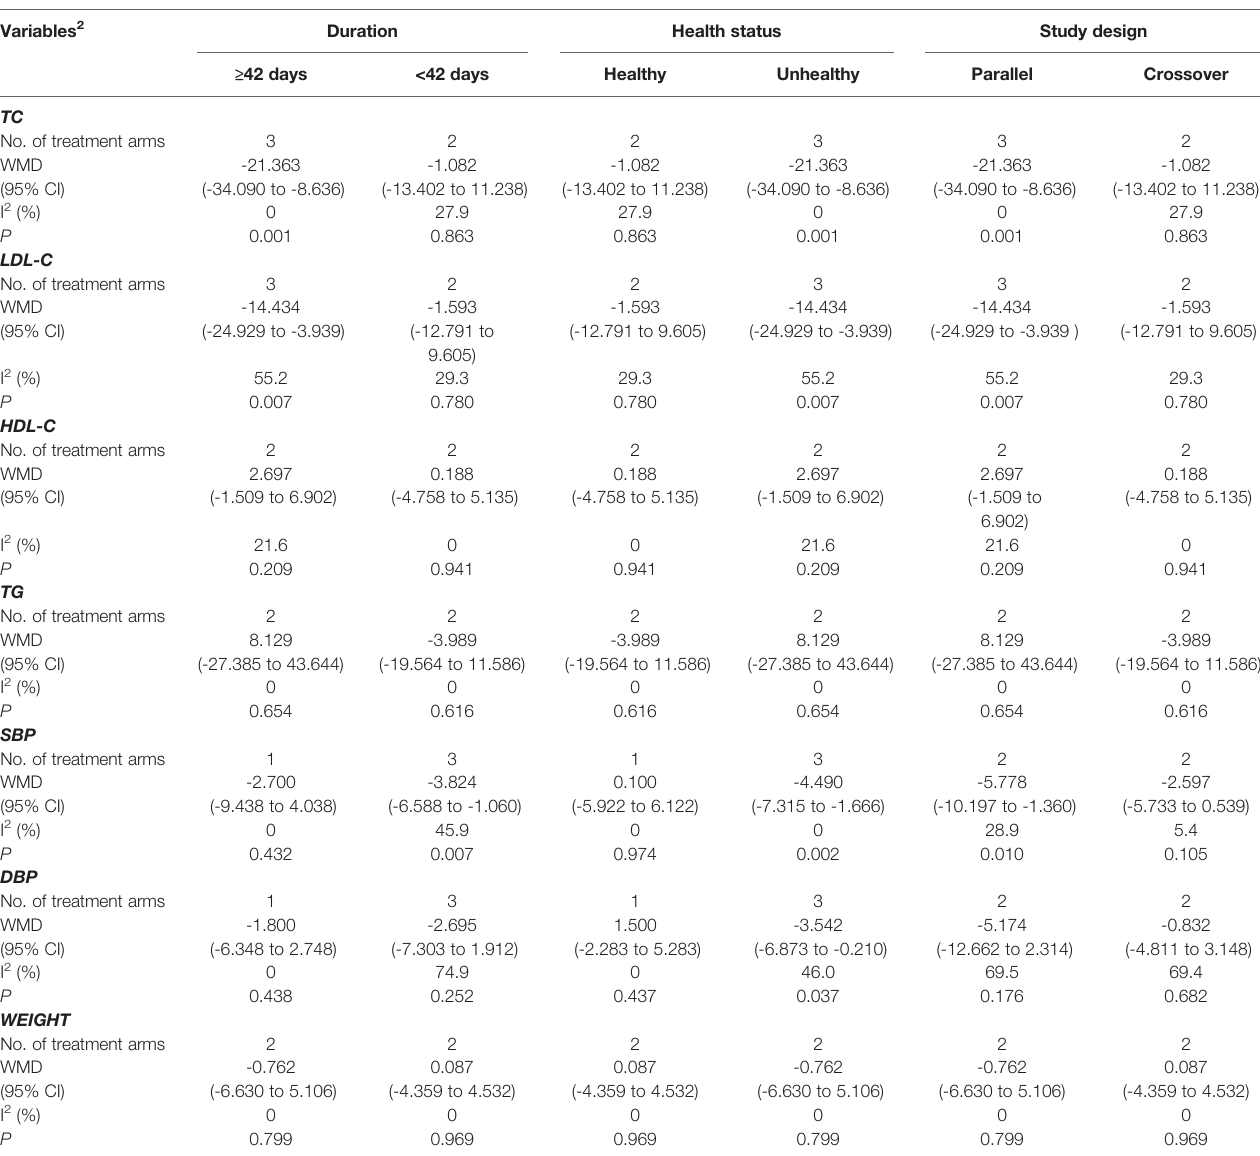
TABLE 4 | Subgroup